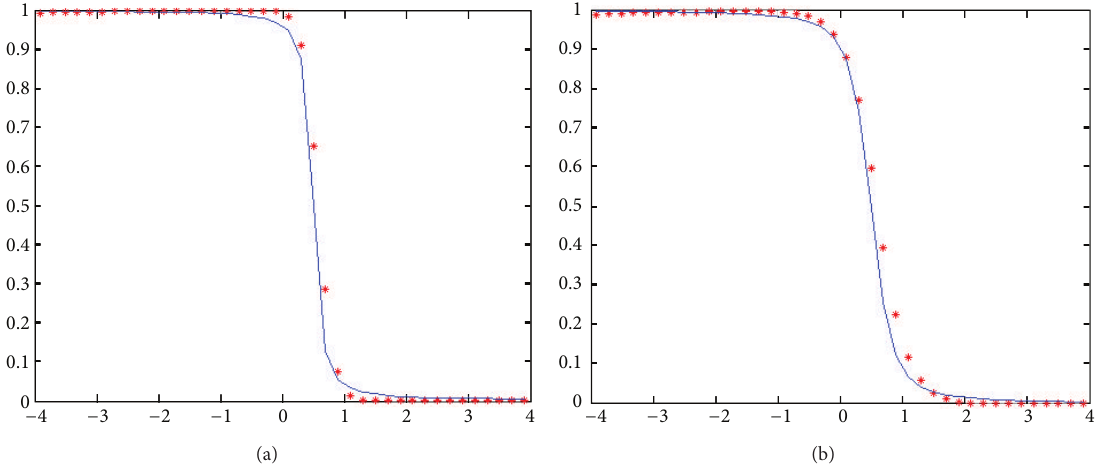
Figure 4: Numerical solution (red line) of methods (26)-(27) taking Δ𝑥 = 0.2 and the exact solution (blue line) of the FADE. The graphic to the left shows the results for 𝜔 = 1.2 and the graphic to the right shows the results for 𝜔 = 1.4 , for both cases Δ𝑥 = 0.2 .